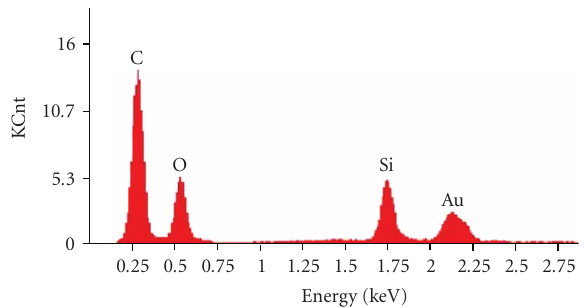
Figure 2: Electron disperse spectrum (EDS) of a 12 PDMS- 1/PDMS-2 bilayered thin film on a gold surface.